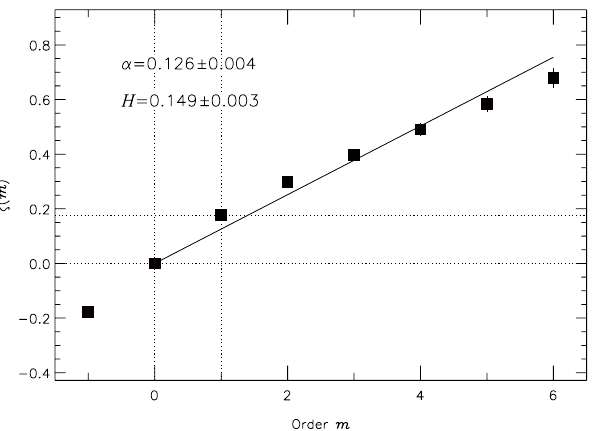
Fig. 8. The relative variation of the sums of the differences ( 6 Diffs) between PDFs and re-scaled PDFs at the next two largest τ versus temporal scale τ and a plausible range of scaling exponents α PDF . The best estimates of α PDF were given by the minima in the sums of the differences across the entire PDF (purple). These results are for all the δ v los samples observed on Tasmania beam 4 (Table